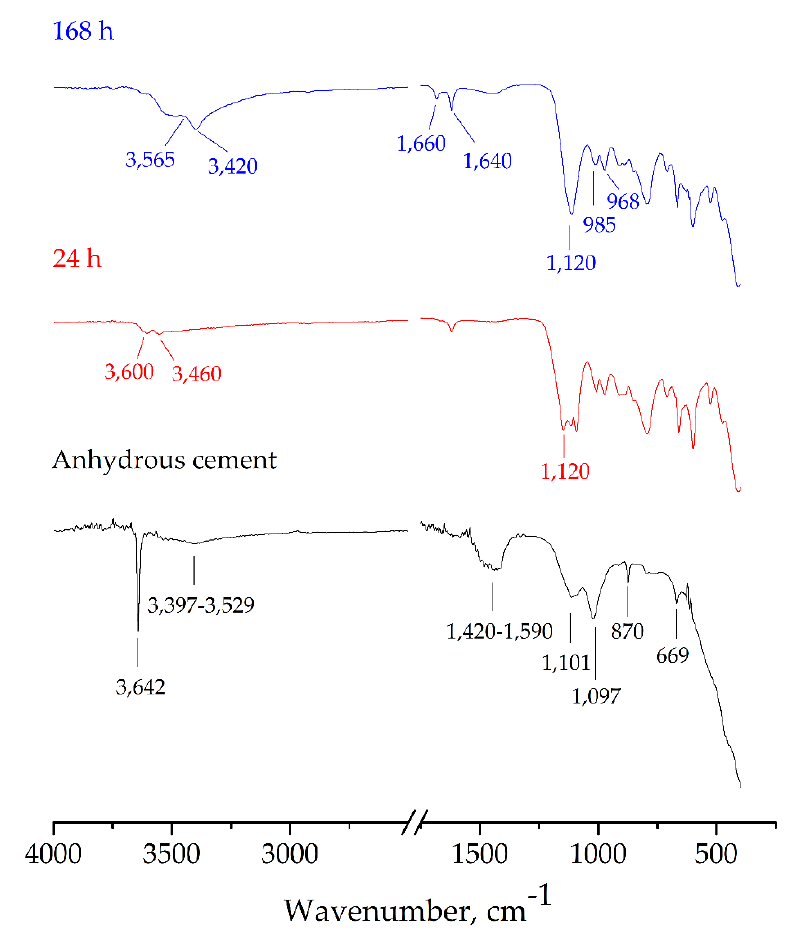
Figure 4. FTIR spectrum of anhydrous cement and hydrated pastes cured for 24 h and 168 h.